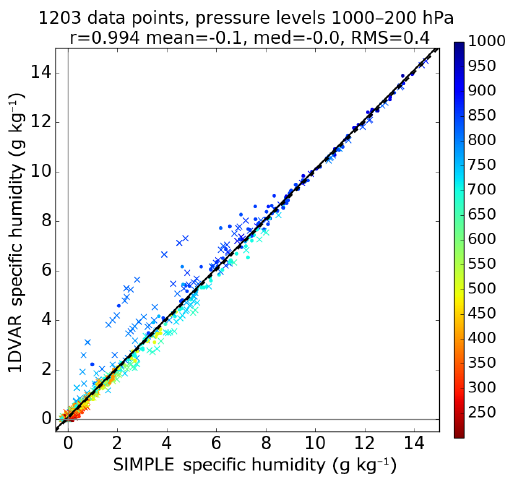
Figure A3. Specific humidity from the RO 1D-Var retrieval com- pared to the RO simple retrieval, using the same profiles as in Fig. A2. Points from profiles for which the collocated radiosonde profile experiences super-refraction are marked by an